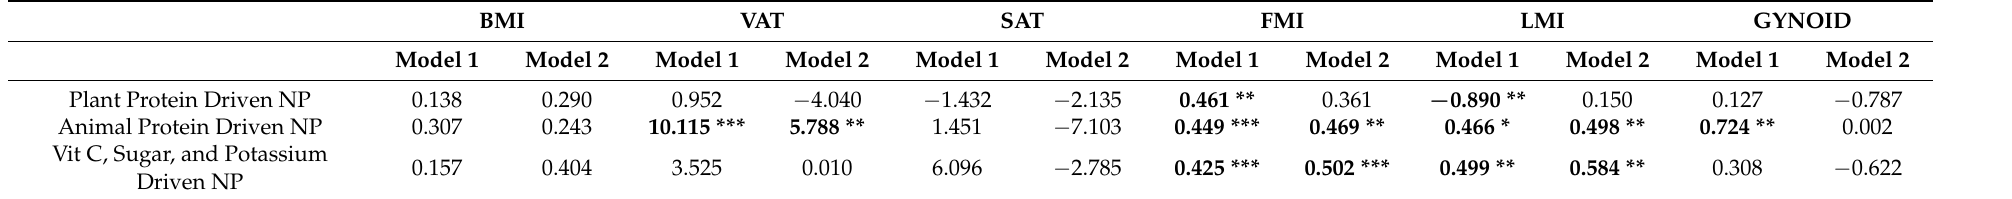
Table 2. GEE β coefficients for repeated measures of nutrient patterns and repeated measures of body composition ( n =